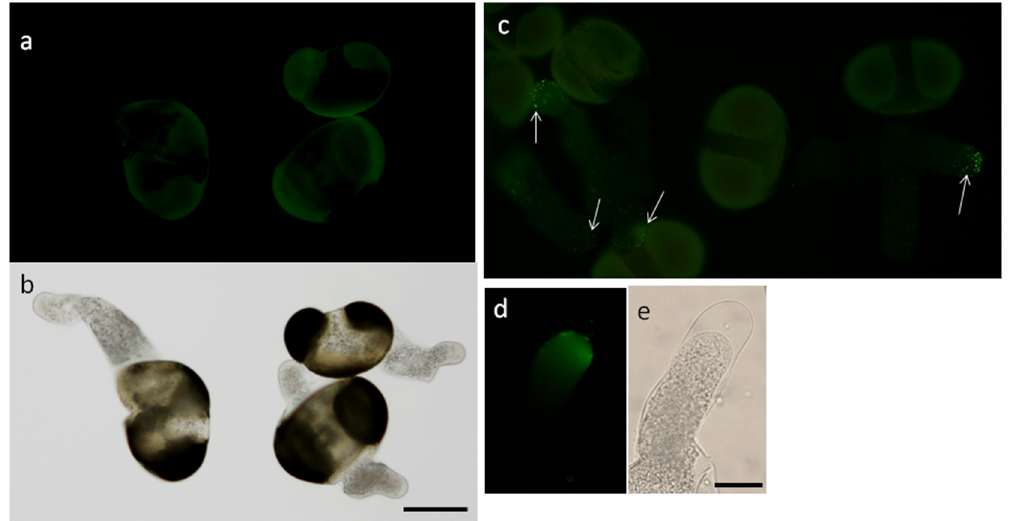
Figure 5. Testing antibodies for specificity . ( a ) Suspension treated with pre-immune rabbit serum + goat anti-rabbit AlexaFluor secondary antibodies—no signal in pollen tubes is detected, only weak exine autofluorescence; ( b ) the same pollen in brightfield; ( c ) suspension treated with rabbit anti- H + -ATPase primary antibodies + goat anti-rabbit AlexaFluor secondary antibodies. Fluorescent signal can be seen almost in all pollen tubes (arrows); ( d , e ) plasmolized pollen tube showing signal localization in the tube apex (focus on the cell wall). Bar: 50 ( a – c ) and 20 µm ( d,e ).